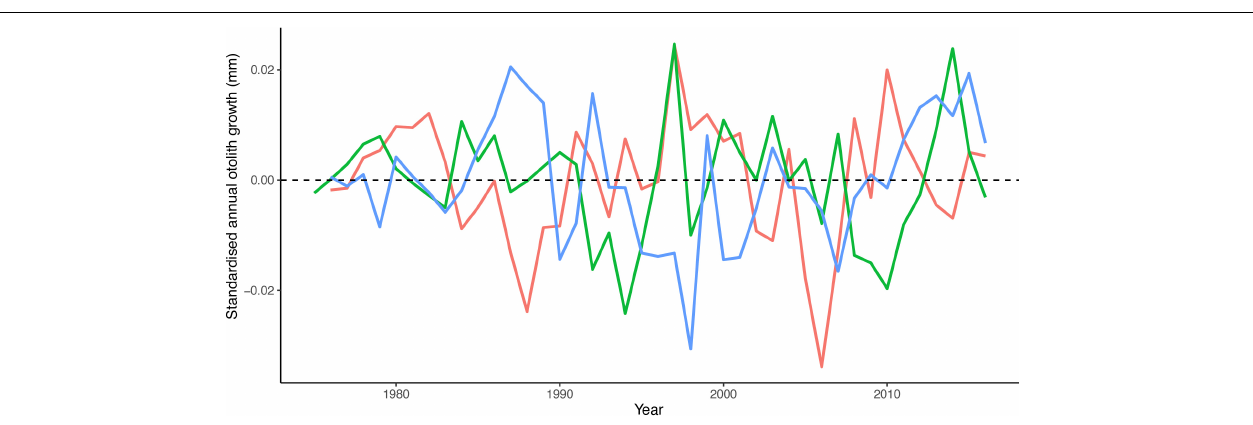
FIGURE 2 | Pagellus bogaraveo predicted variations in annual otolith growth collected in Western (blue), Central (red), and Eastern (green) island